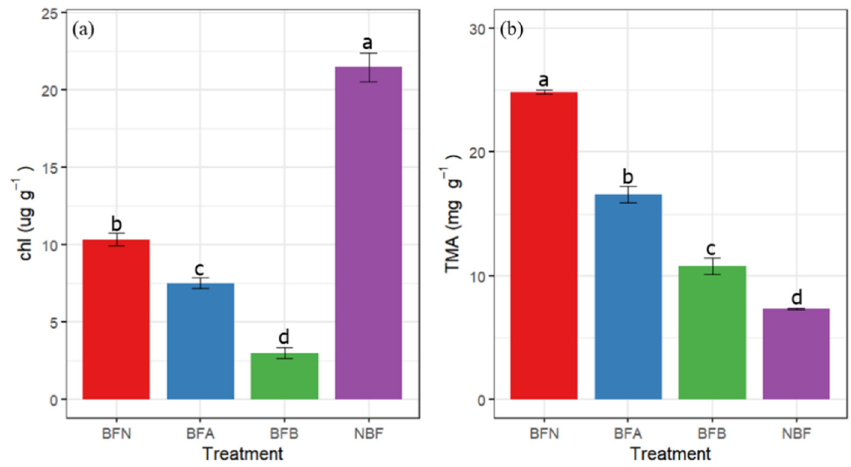
Figure 6. Effects of sunburn on pigment. ( a ) Chlorophyll (Chl), and ( b ) total monomeric anthocyanin (TMA). Vertical bars are the mean ± SE ( n = 3). Different letters above the bars indicate significant differences at the 0.05 level by Duncan’s multiple range test. Table 1. Effects of sunburn on composition of phenolic